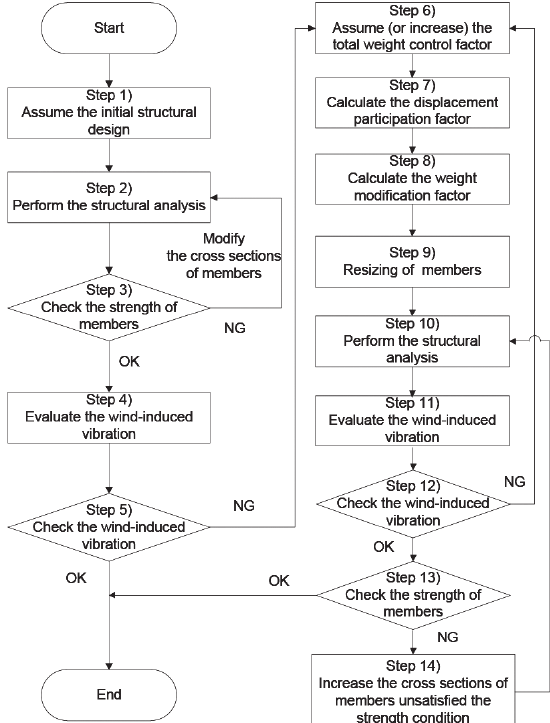
Fig. 2. Design model to control the wind-induced responses of a high-rise building